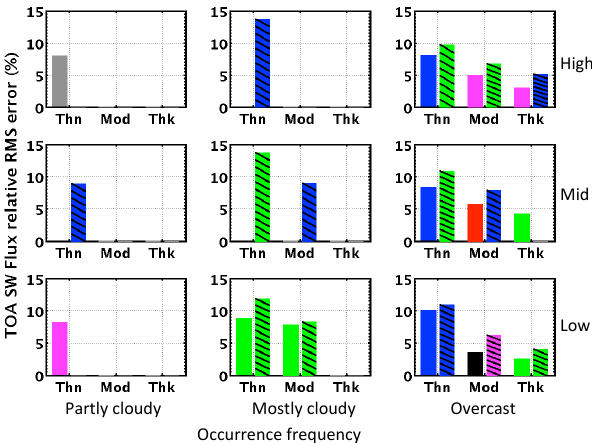
Figure 8. Same as Fig. 6, but over snow and